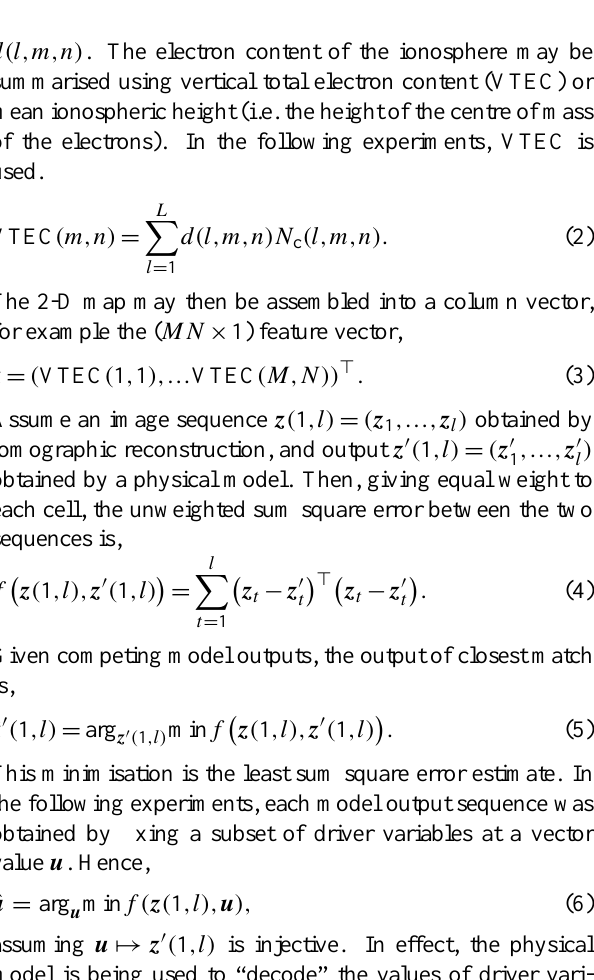
Fig. 1. Hourly measurements for Dst and Bz, and three-hourly mea- surements for Ap (see OMNIWeb, access: July 2010 and the Ac- knowledgments).